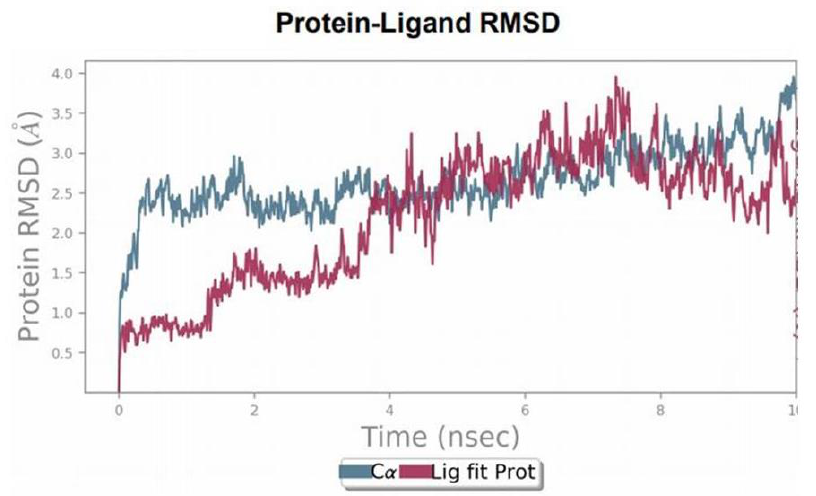
Figure 3. An oncometabolite SAICAR displays stable complex with PKM2. PKM2–SAICAR root mean square deviation (RMSD) plot for 10ns of time frame showing the stability of the complex between SAICAR depicts strong and specific binding to